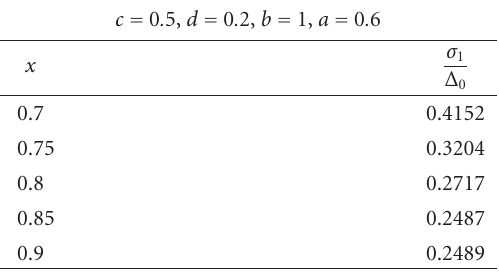
Table 4.1. Numerical results for problem